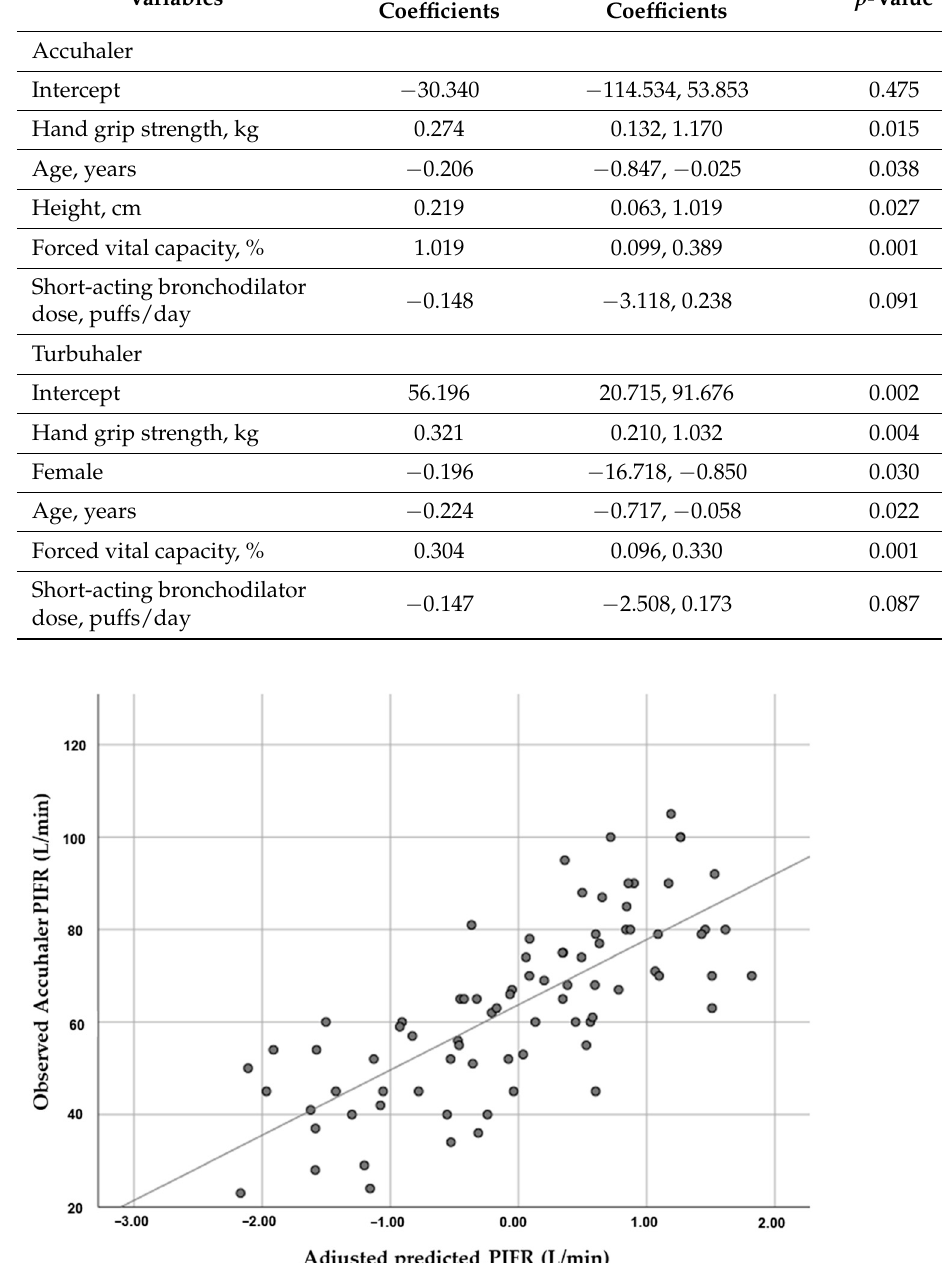
Table 4. Linear regression analysis for peak inspiratory flow rate and hand grip strength adjusted by age, gender, height, forced vital capacity, and short-acting bronchodilator dose.